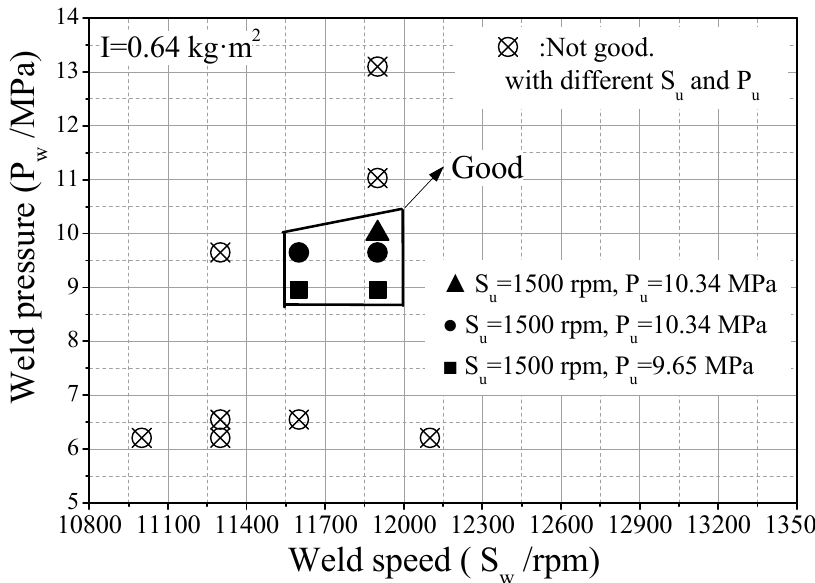
Figure 8. The quality of welding with different friction welding parameters.